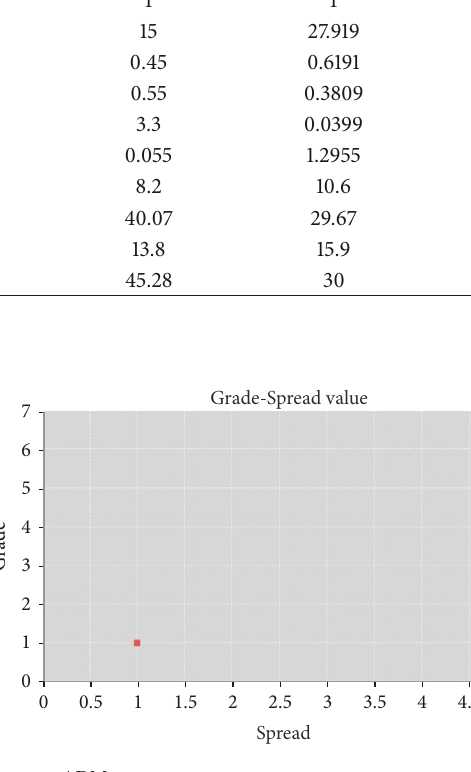
Figure 10: Grade-Spread value obtained by FSV applied to MSS FST#2peaks results [20] and its approximation by 2P- AEF(2,1,2) using GA for parameters